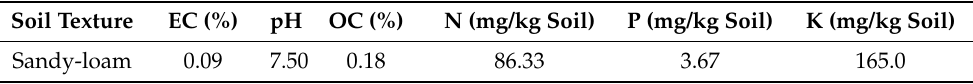
Table 1. Properties of soil in the pots under the screen house